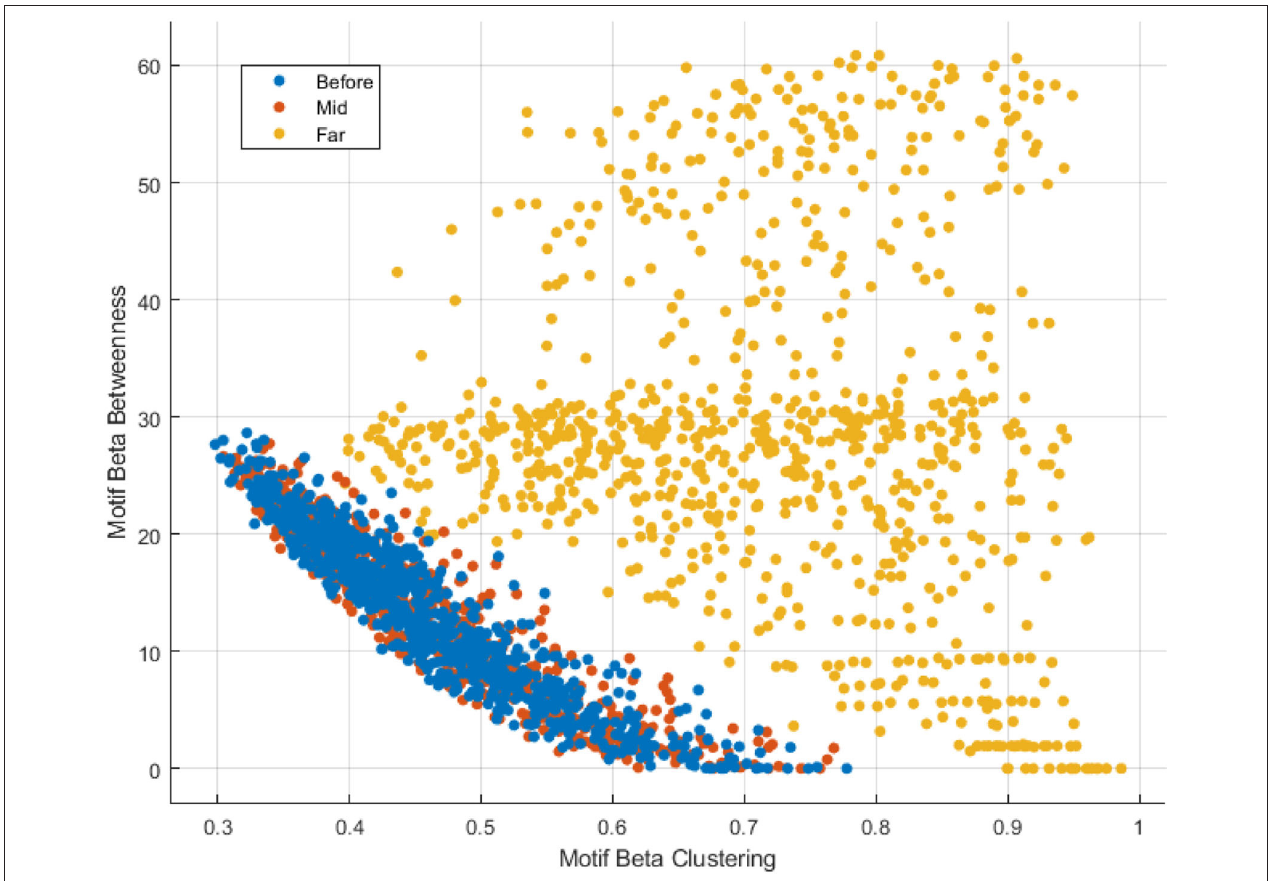
FIGURE 12 | Scatterplot of global graph metrics (clustering coefficient vs. betweenness centrality) for motifs in the beta band with 2,640 data points. As indicated by the ANOVA comparisons, the distributions for the mid and before classes are highly separable against the far distribution using these metrics but not among